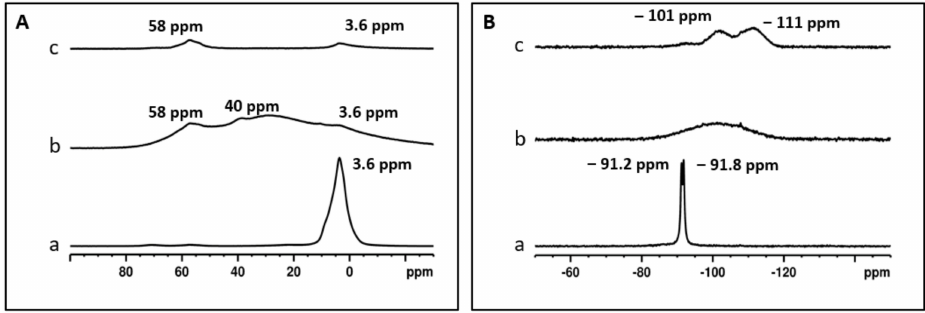
Figure 2. 27 Al MAS-NMR ( A ) and 29 Si MAS-NMR ( B ) spectra of kaolinite (a), metakaolin (b), and silica particles